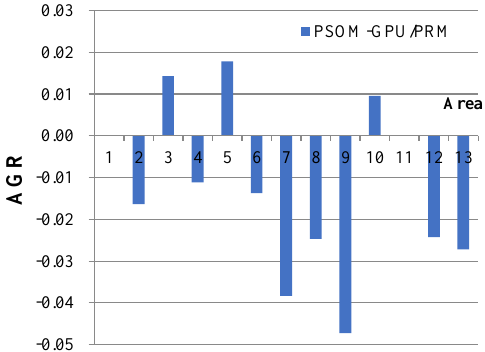
Figure 7. Algorithm accuracy P of PRM and PSOM-GPU in thirteen areas (Areas 1 – 13). Figure 8. Accuracy growth rate (AGR) of PSOM-GPU and Figure 8. Accuracy growth rate (AGR) of PSOM-GPU and PRM.